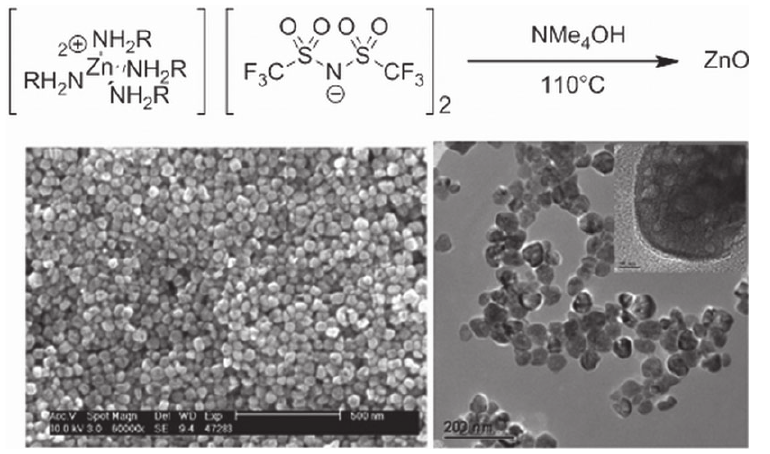
Figure 3 IL precursor for ZnO NP synthesis. Bottom, SEM (left) and TEM (right) images of ZnO NPs resulting when R = octyl. © ACS. Adapted with permission from [71]